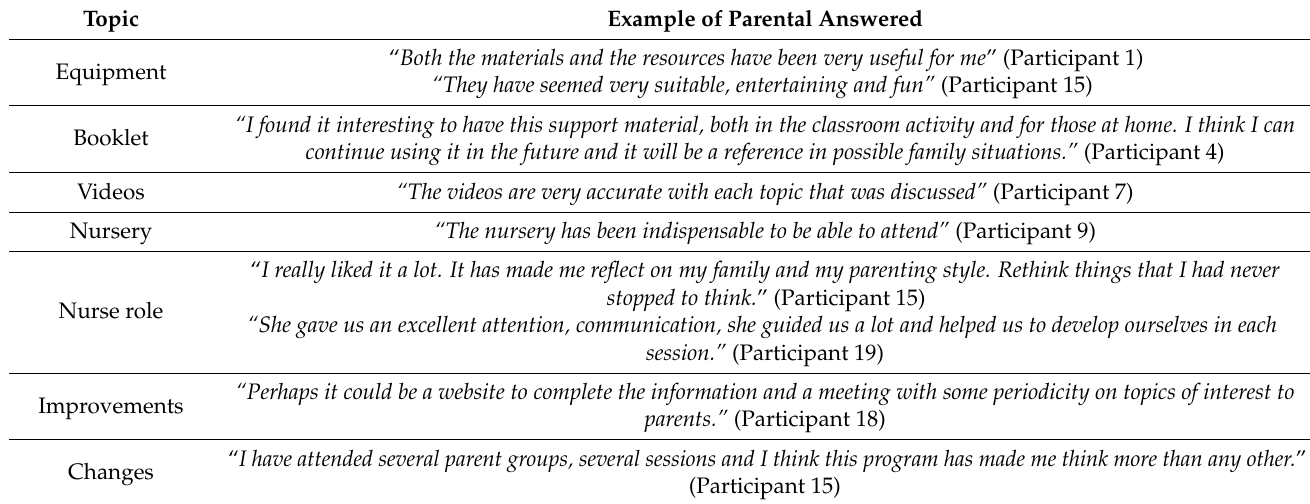
Table 3. Content analysis